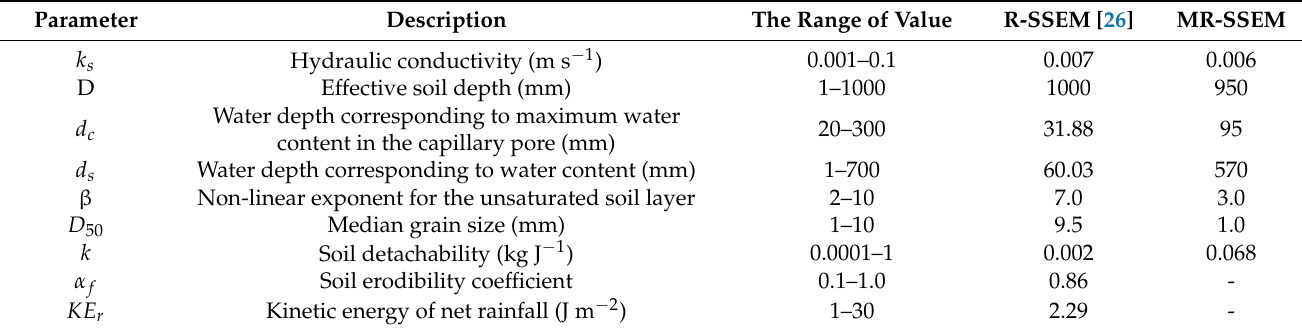
Table 7. The optimal parameters used in R-SSEM and MR-SSEM.